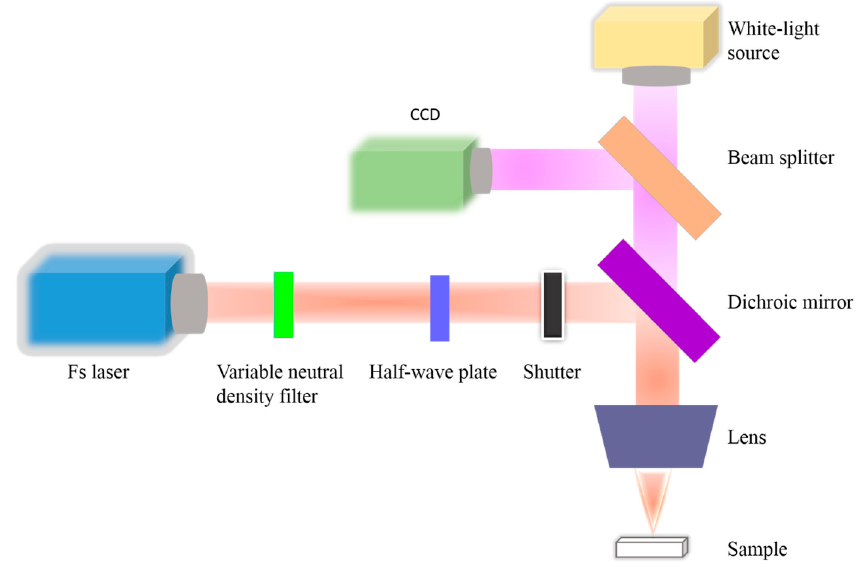
Figure 1. Schematic diagram of experimental